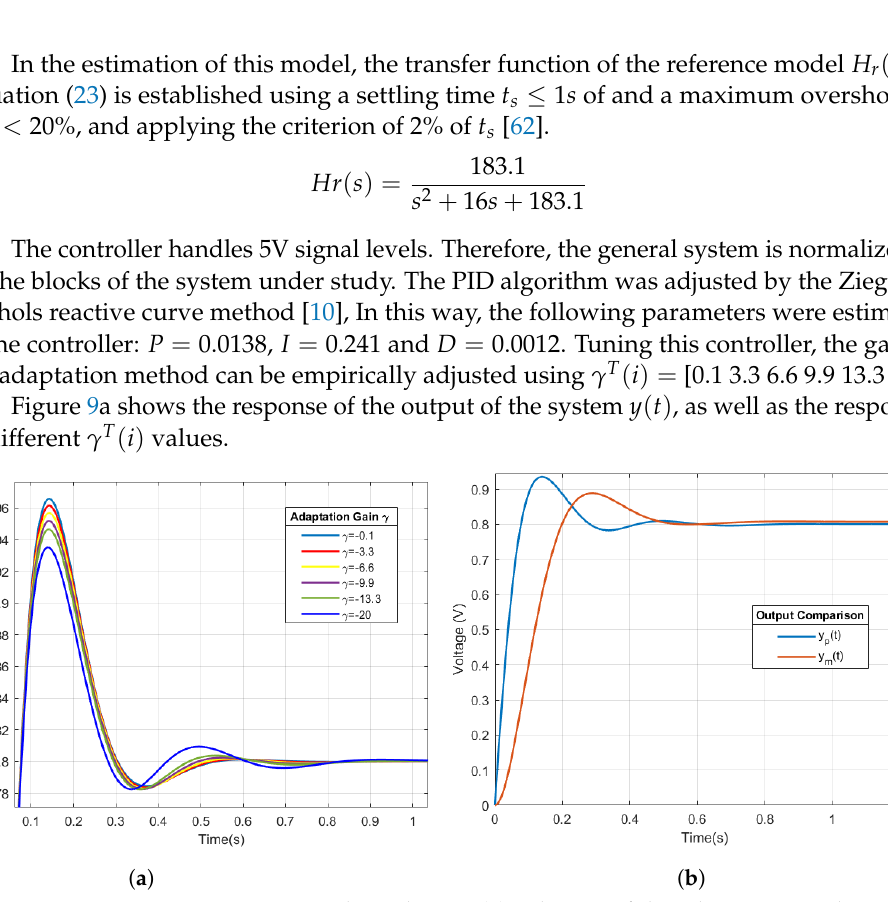
Figure 9. System output response and regulation. ( a ) Behavior of the adaptation mechanism γ i . ( b ) Response of the HRV system y ( t ) respect to the reference model y r ( t ) .